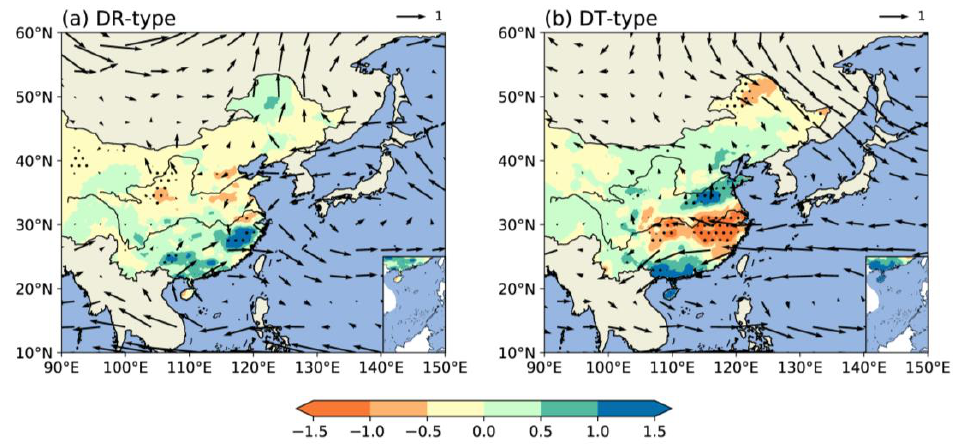
Figure 3. Composite summer horizontal wind anomalies at 850 hPa (vector, units: m · s − 1 ) and precipitation anomalies (shading, units: mm) for ( a ) DR-type and ( b ) DT-type. The precipitation anomalies significant at the 90% confidence level are dotted.